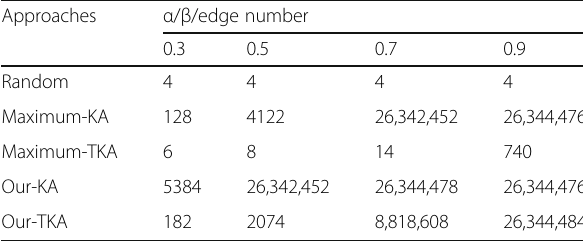
Table 3 The different parameters are employed in the weighted similarity function WJC, and λ = 0.3 to obtain the edge number values